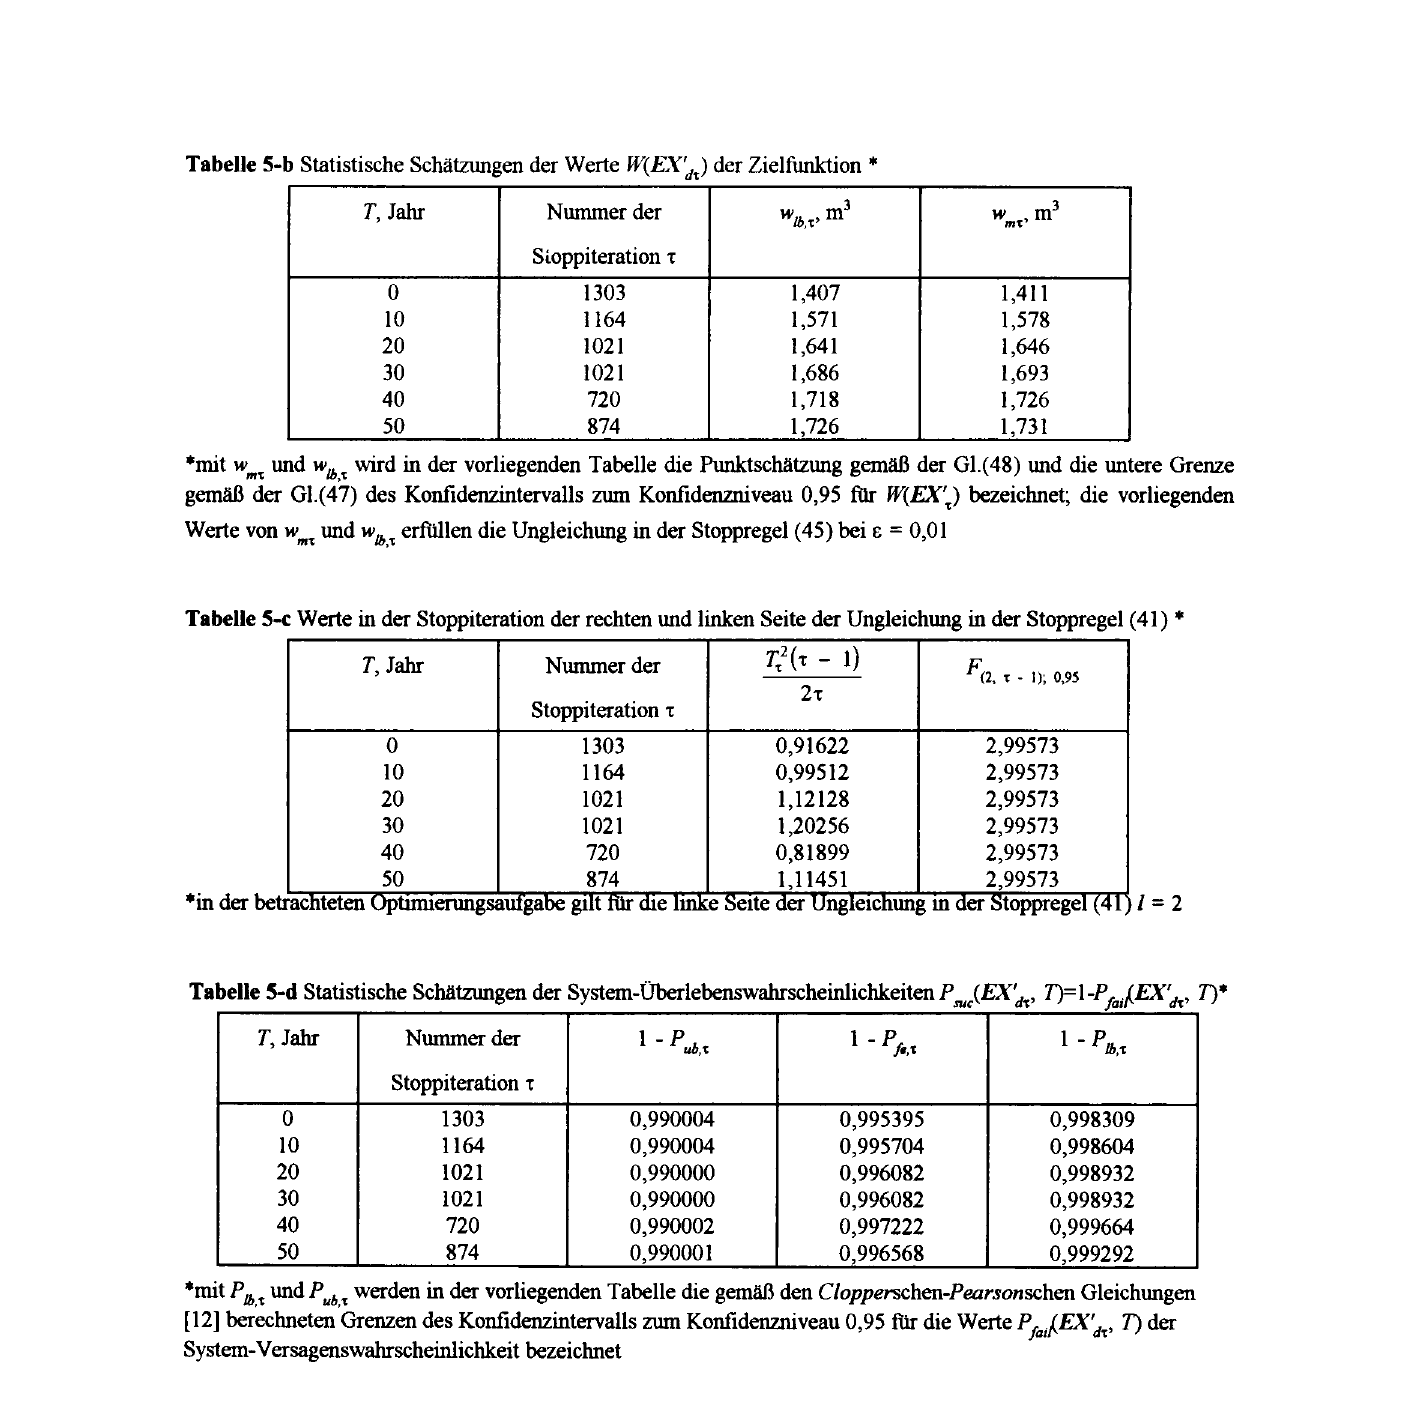
Auf ahnliche Weise kann man bei der Betrachtung der Losungsergebnisse der Optimierungsaufgabe (34) aus den Punkten (Ed,, T ), (EAsd.t' T) und (wnn, T) mit den in den Tabellen 5-a und 5-b angefiihrten Koordinaten Polygonziige bilden (Bilder 8 und 9). Man kann dann die Polygonziige als graphisch dargestellten statistischen Schatzungen der Kurve